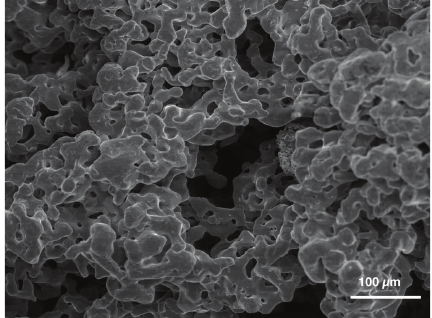
Figure 2: A porous titanium granule (PTG) seen with SEM. Particle size 500–1000 𝜇 m with a total porosity of approximately 80%.